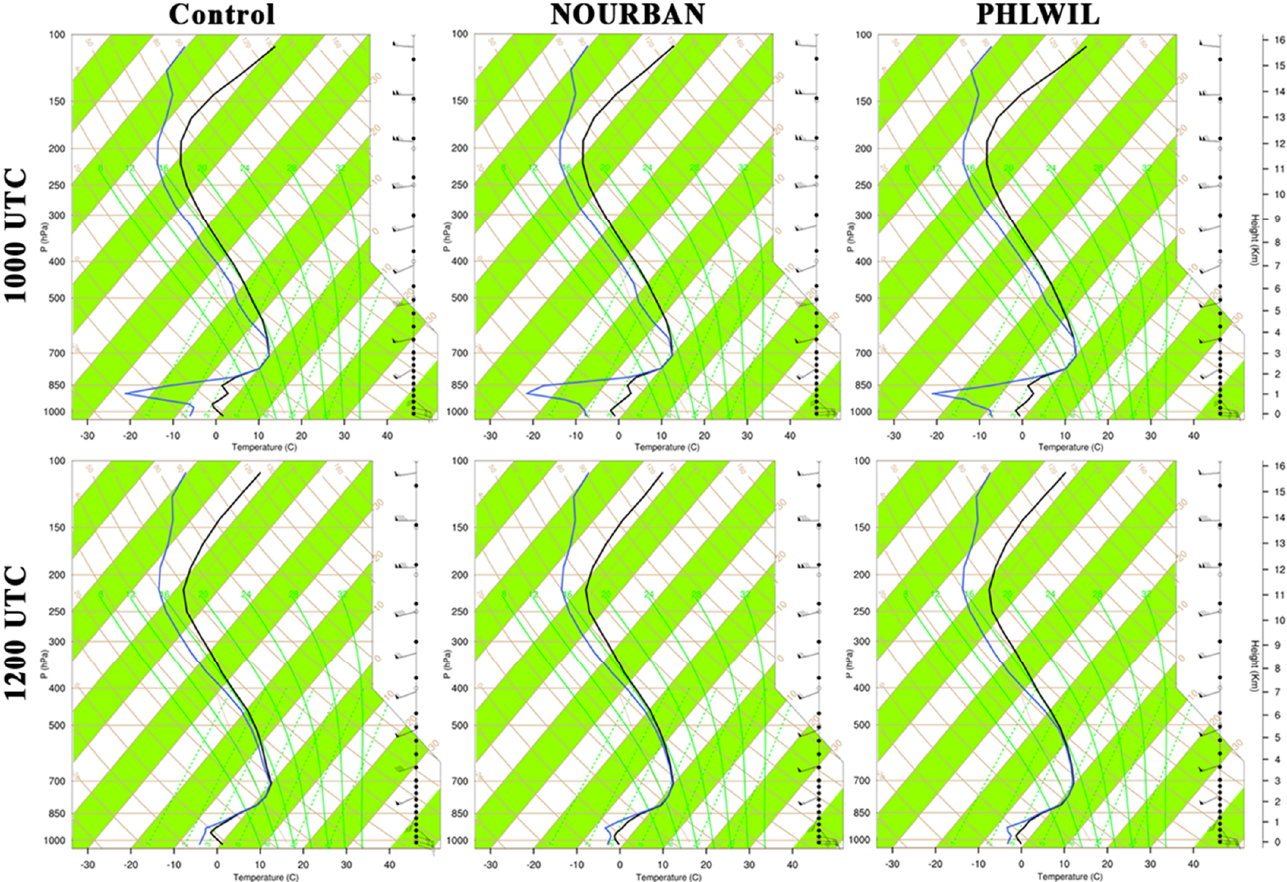
Figure 10. WRF-simulated vertical atmospheric soundings at Philadelphia, PA over the control, NOURBAN, and PHLWIL simulations. Valid at 1000 and 1200 UTC on 6 February 2004. Black and blue lines are temperature and dewpoint (°C), re- spectively.